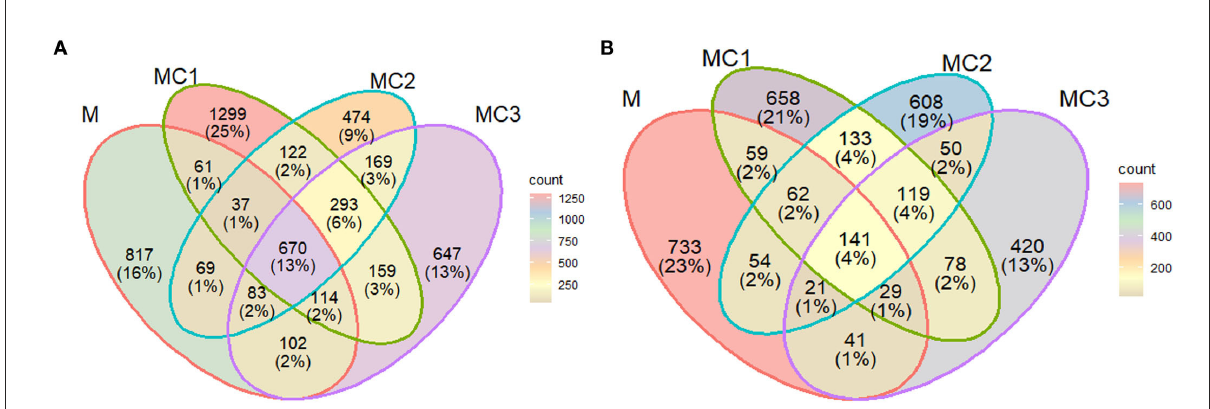
FIGURE1 Venn diagram based on ASVs at the first (A) and third (B) year of the experiment. M, melon monocrop; MC1, mixed intercropping; MC2, intercropping row 1:1 melon:cowpea; MC3, intercropping row 2:1 melon:cowpea. The numbers (percentages) of the abundant bacteria in different systems are indicated in the overlapping and non-overlapping